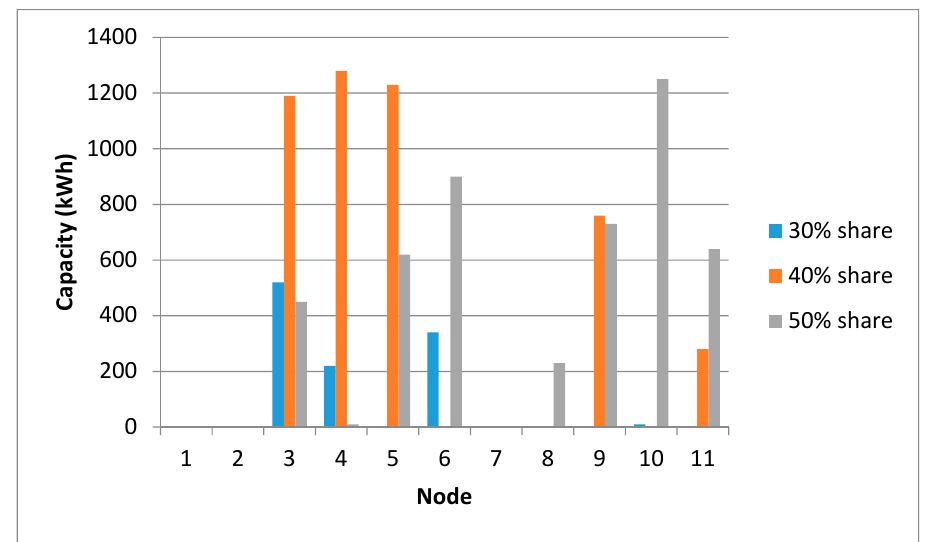
Figure A10. Capacity structure for energy storages in the context of share of energy from RES in total demand.